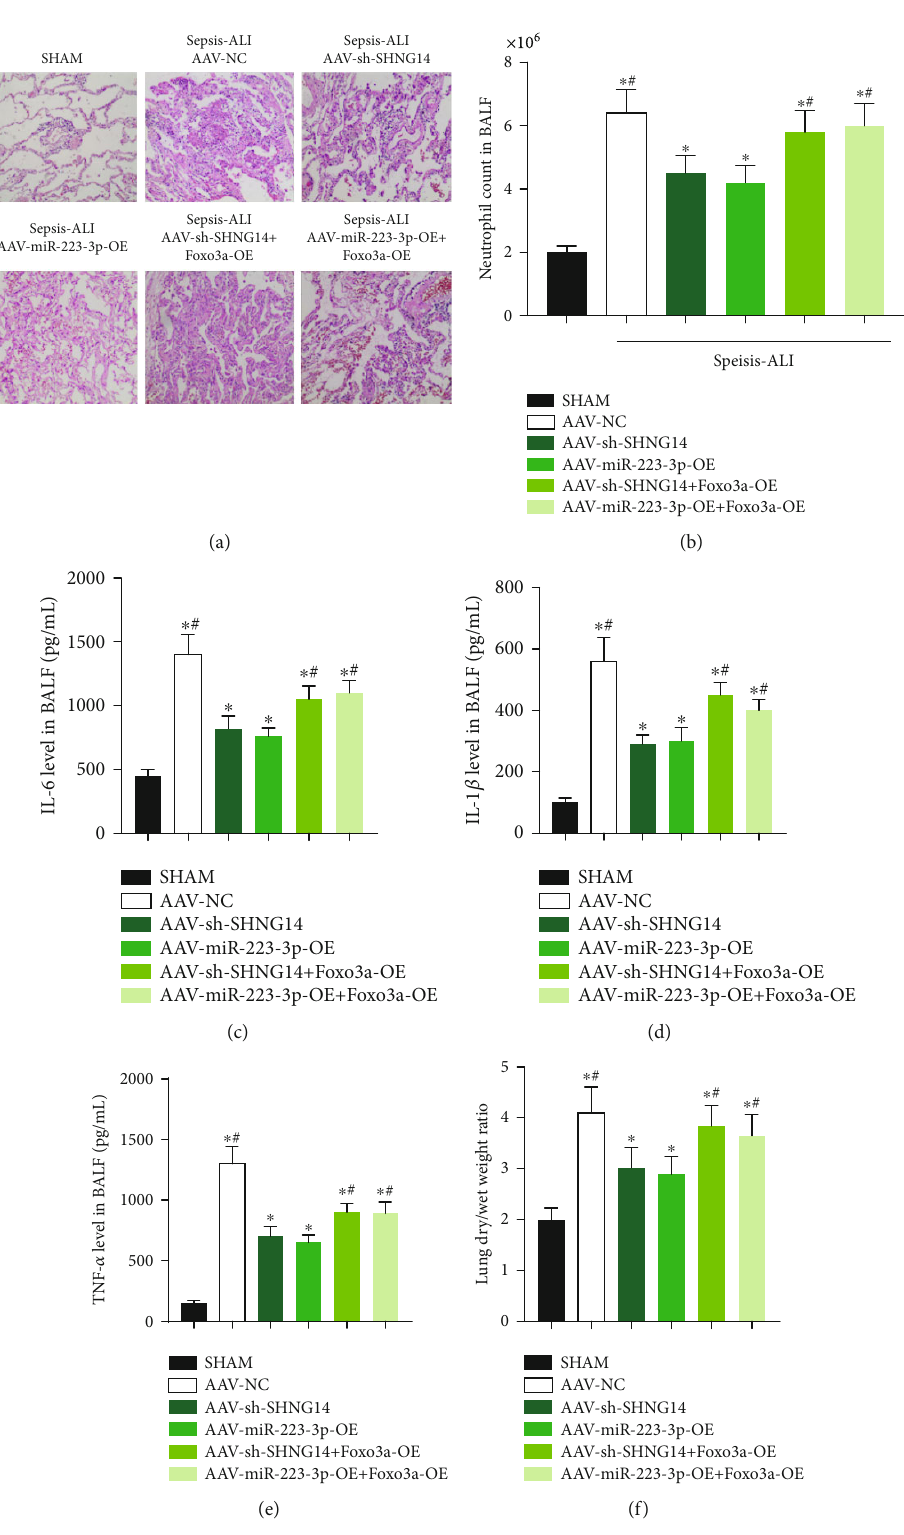
Figure 5: lncRNA-SNHG14/miR-223-3p/Foxo3a axis played a role in the LPS-induced ALI mice model. Animals were administered with AAV-SNHG14, AAV-miR-223-3p-OE, AAV-SNHG14+ AAV-Foxo3a-OE, and AAV-miR-223-3p-OE +AAV-Foxo3a-OE 2 weeks before LPS treatment, respectively. After 12 h of LPS instilling. Lung tissue samples were collected; lung injury level was estimated by pathological section ((a) hematoxylin-eosin staining). Bronchoalveolar lavage fl uid (BALF) was collected. Neutrophil count (b), IL-6 (c), IL-1 β (d), and TNF- α (e) levels in BALF were determined. (f) Lung wet/dry weight ratio was measured. ∗ P < 0 : 05 compared with the Sham group; # P < 0 : 05 compared with the mice treated with AAV-SH-SNHG14 or AAV-miR-223-3p-OE